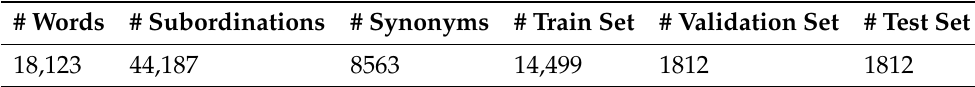
Table 2. Overview of the built experimental dataset.